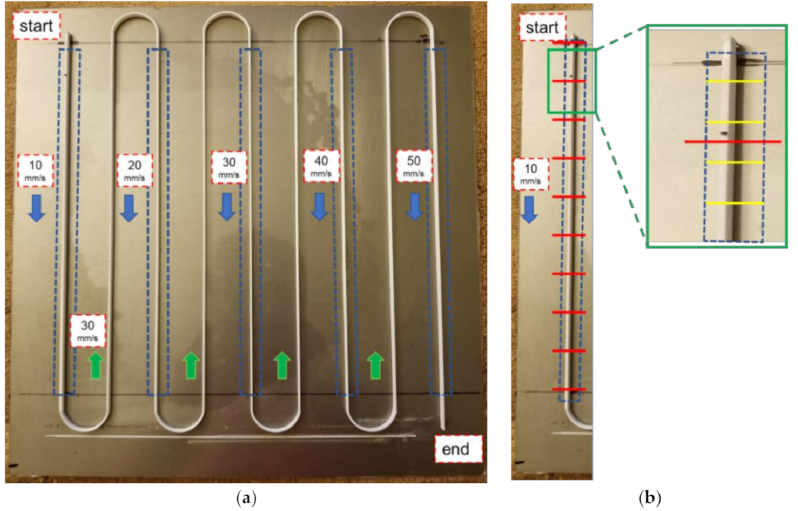
Figure 9. ( a ) Test specimen for in-situ vision-based extrusion width measurement consisting of deposition paths of varying speeds highlighted in a blue dashed rectangle (200 mm). ( b ) Caliper mea- surement scheme at red intervals (20 mm). Yellow lines are locations of repeatability measurements in the vicinity of a single red